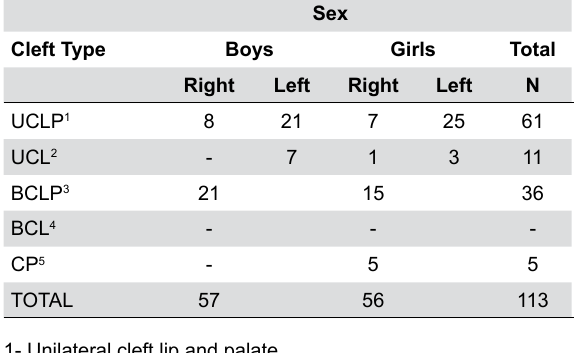
Table 1- Analysis of cleft types according to sex